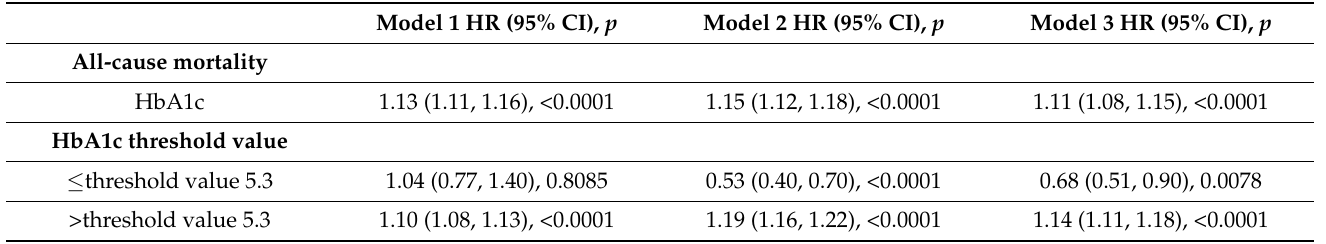
Table 2. Multivariate Cox regression analysis of HbA1c with all-cause and cardiovascular